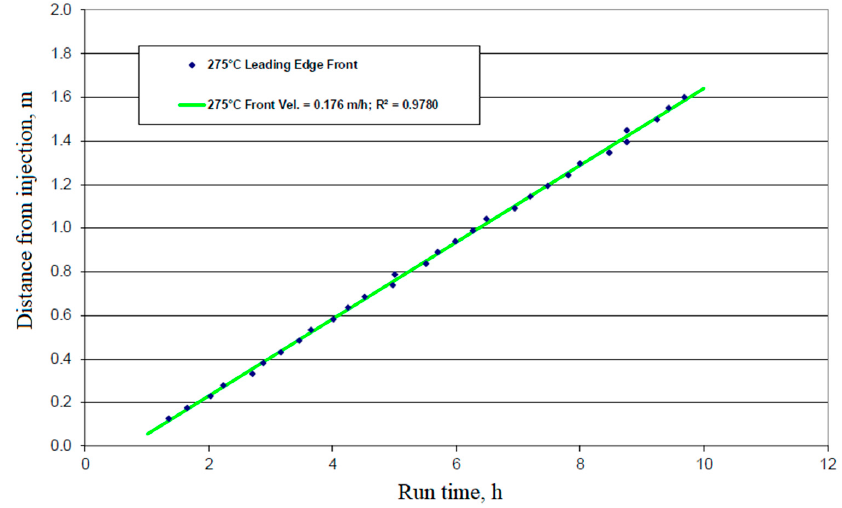
Figure 4. Forward Combustion Front Locations.